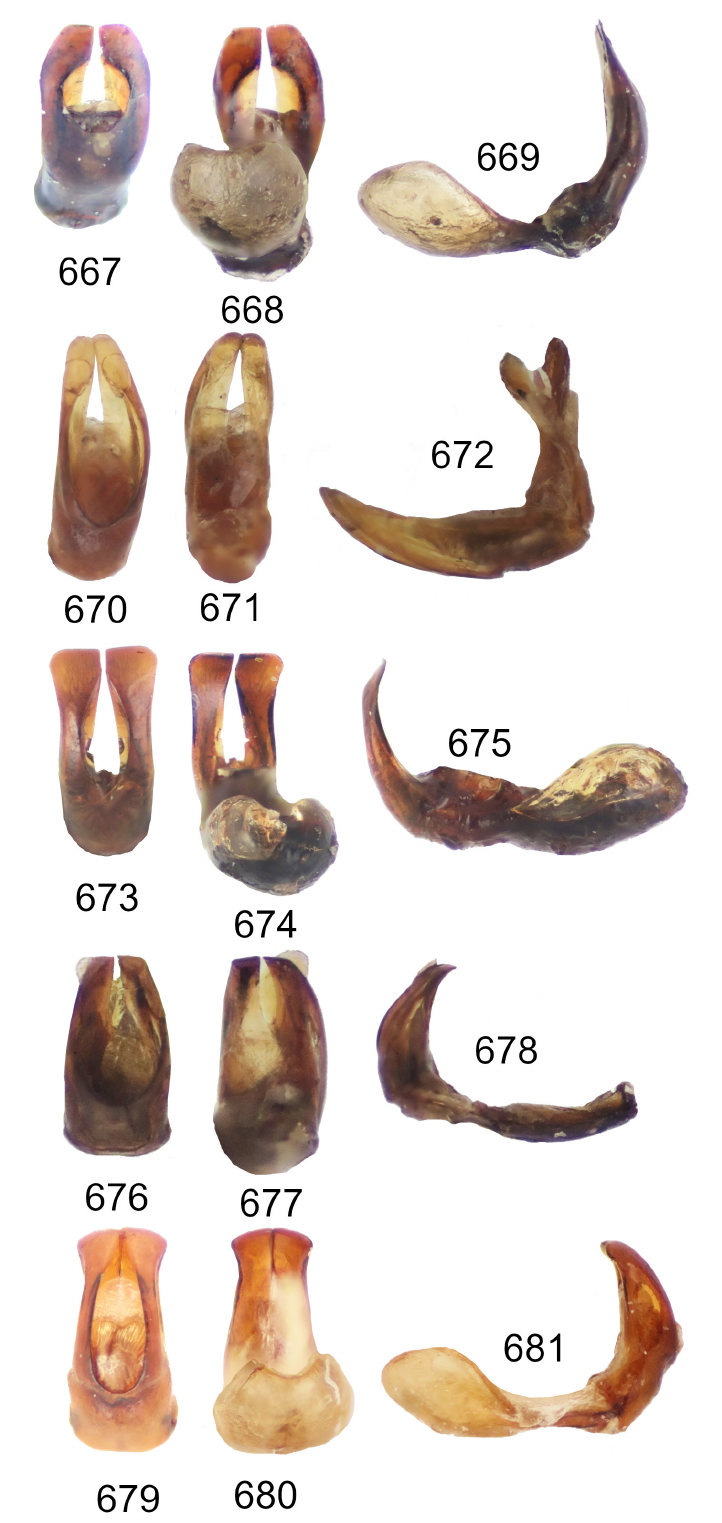
Figs Papuan Maechidius Macleay,